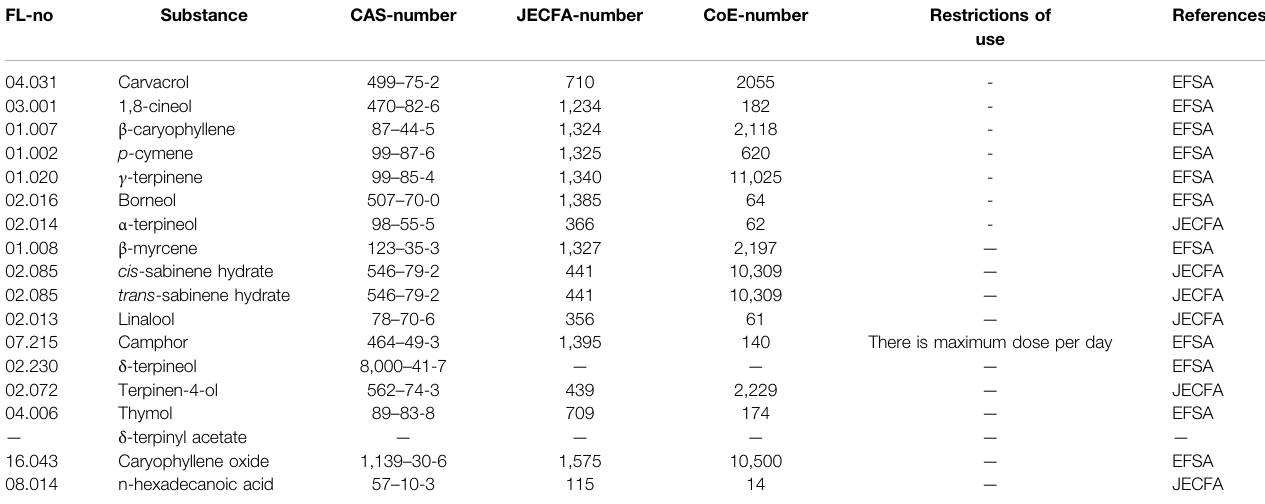
TABLE 6 | Chemical constituents of herb essential oil preparations, which are included in the Union List of Flavourings and Source Materials (Commission Implementing Regulation (EU) No 872/2012 of October 1, 2012) based on EFSA and/or JECFA evaluations.